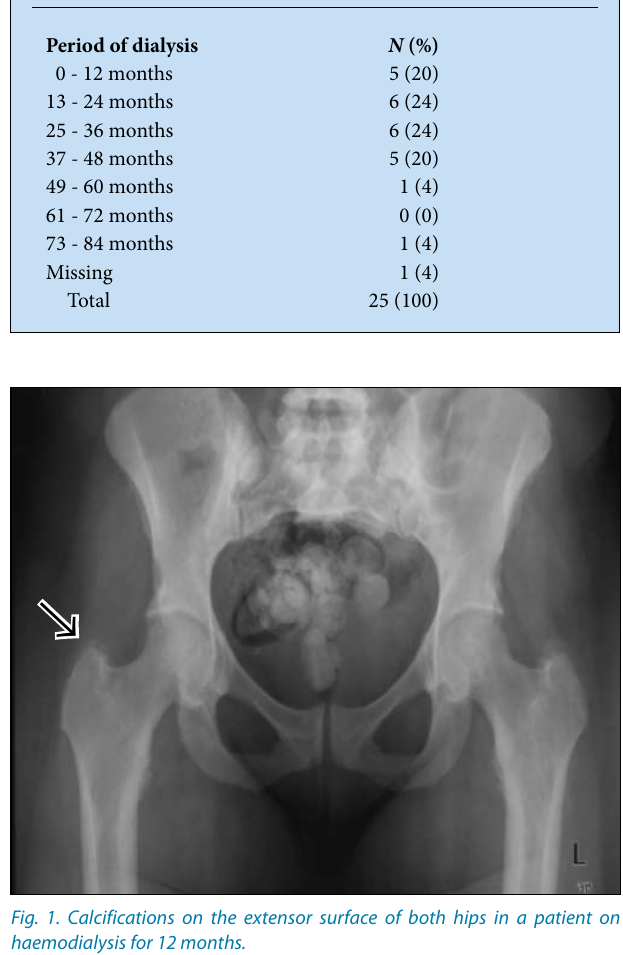
Fig. 1. Calcifications on the extensor surface of both hips in a patient on haemodialysis for 12 months.